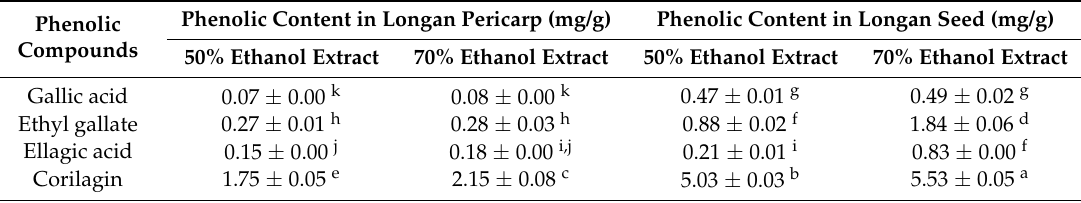
Table 2. Quantification of polyphenolic compounds in longan byproducts by HPLC analysis. Phenolic